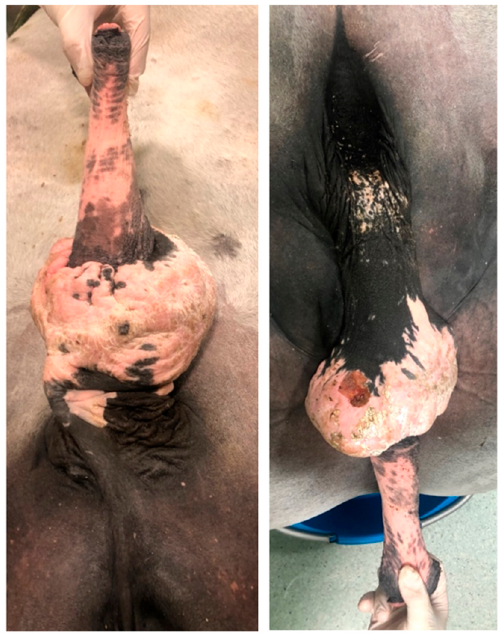
Figure 4. Appearance of the phimosis caused by preputial mass on admission (clinical case 2). By administering xylazine (0.5 mg/kg intravenously (IV)) and applying traction, the free portion of the penis could be extracted and extended through the acquired stenosis of the preputial ring, and the inner lamina of the internal preputial fold could be exam- ined, to assess that it was not involved (Figure 5).